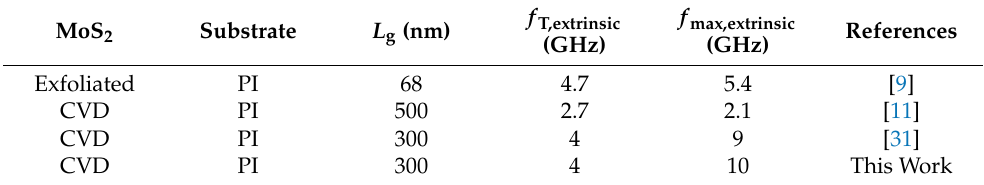
Figure 5. ( a ) Small-signal current gain | h 21 | versus frequency of flexible MoS 2 transistors with gate lengths of 0.3 µ m, 0.6 µ m, and 1 µ m. ( b ) The corresponding unilateral power gain versus frequency. Table 1. Comparison of flexible high-frequency transistors based on 2D MoS